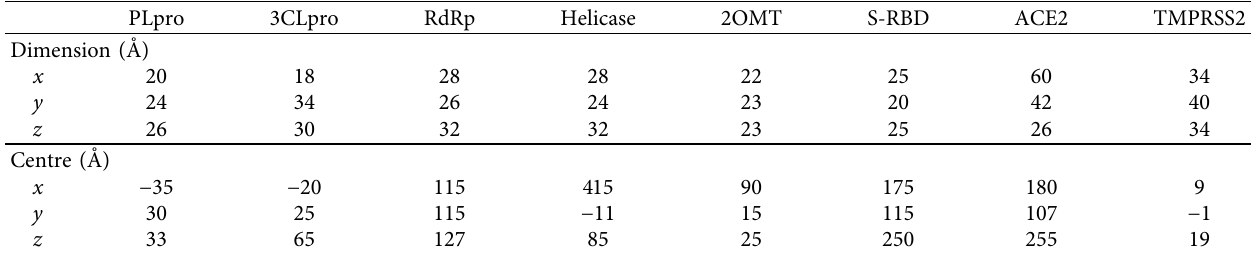
Table 1: Grid box coordinates and size parameters used for molecular docking.